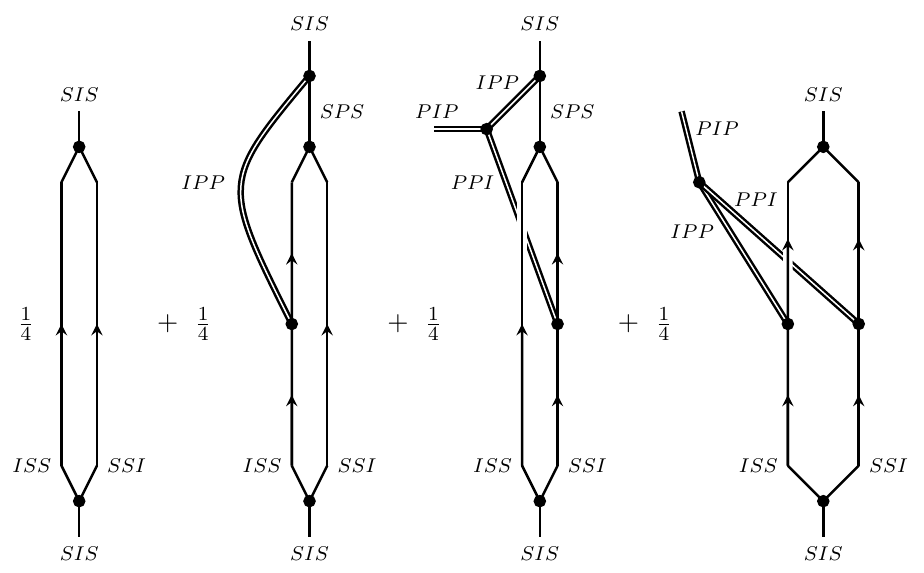
Figure 25 . The (cid:12)gure depicts various terms in the computation of ISS + (cid:10) SSI + . We need to convert SPS into SIS using the chosen isomorphisms. This results in junctions of the three bosonic lines with appropriate signs. After taking into account various factors from associators, crossings and junctions, we obtain ISS + (cid:10) SSI + ’ SIS +